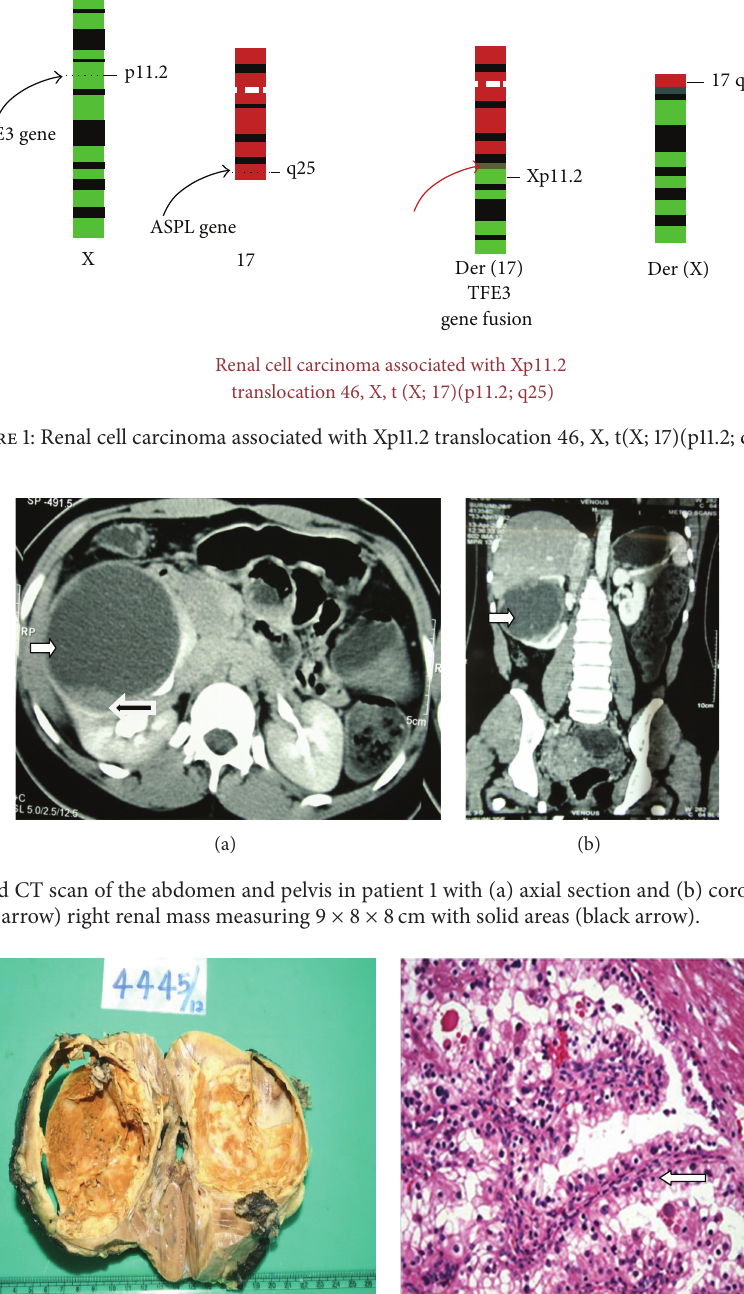
measuring 7.5 × 9 × 7 cm (Figure 3(a)). Pathological findings in patient 2 revealed well defined encapsulated grey white to yellow white solid/cystic lesion in midpole of right kidney measuring 3 × 3 × 5 cm. None of the patients had any sinus fat